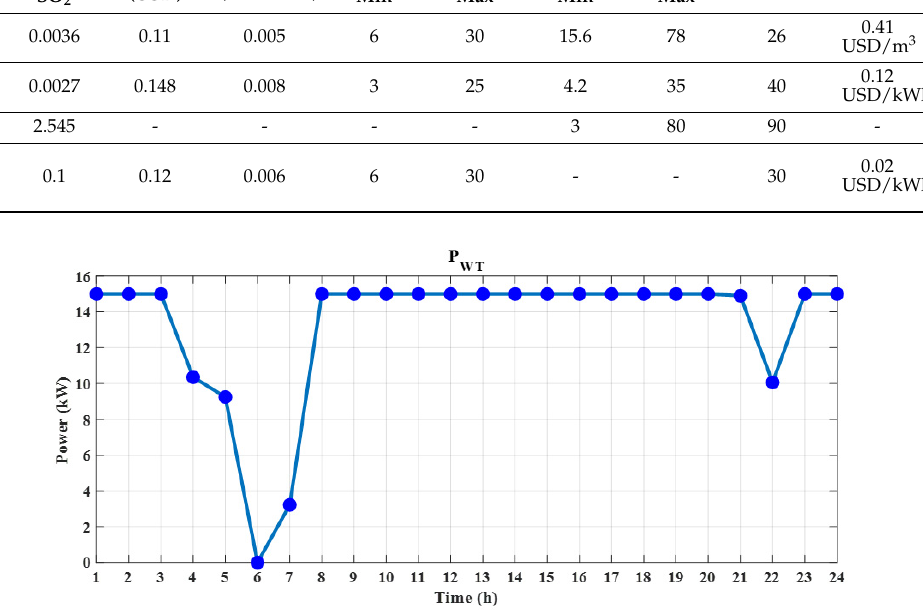
Figure 4. Daily electric power generated by wind turbines.